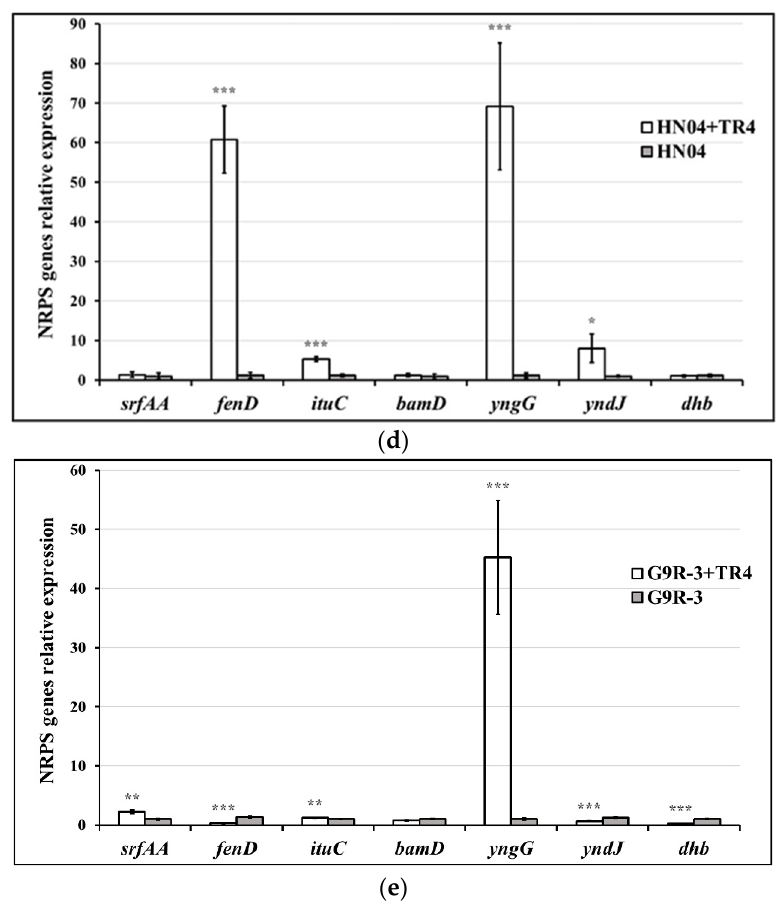
Figure 5. Biocontrol NRPS gene ( srfAA , fenD , ituC , bamD , yngG , yndJ and dhb ) expression profiles of five Bacillus strains: N67, YN1282-2, WBN06, HN04 and G9R-3. ( a – e ): each represent NRPS gene’s expression profiles of N67, YN1282-2, WBN06, HN04 and G9R-3, respectively. The asterisk represents a significant difference in gene expression between single and dual-cultured (Student’s t -test: 0.01 < p < 0.05 “*”, p < 0.01 “**”, p < 0.001 “***”).